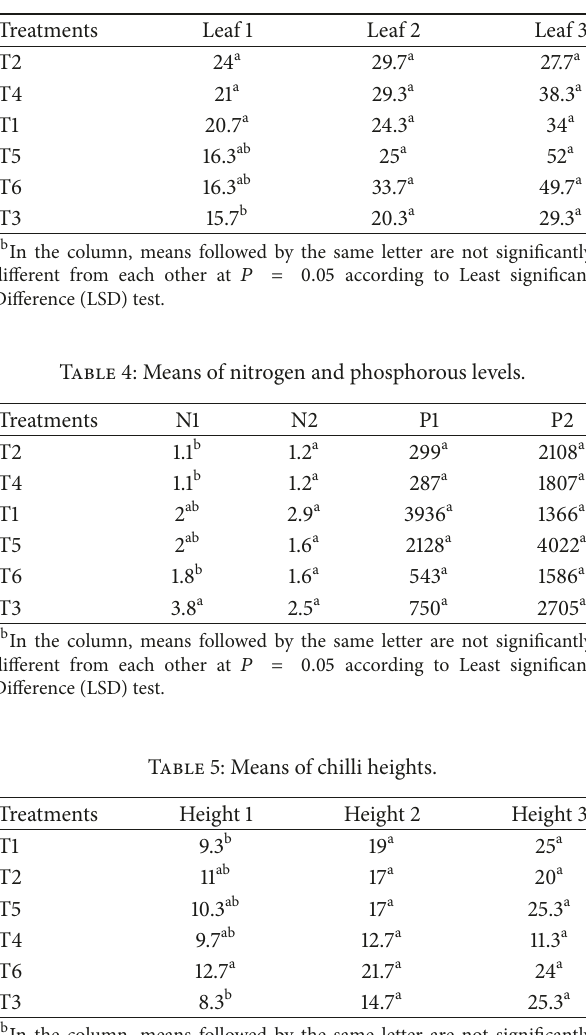
Table 3: Means of chilli leaf numbers.